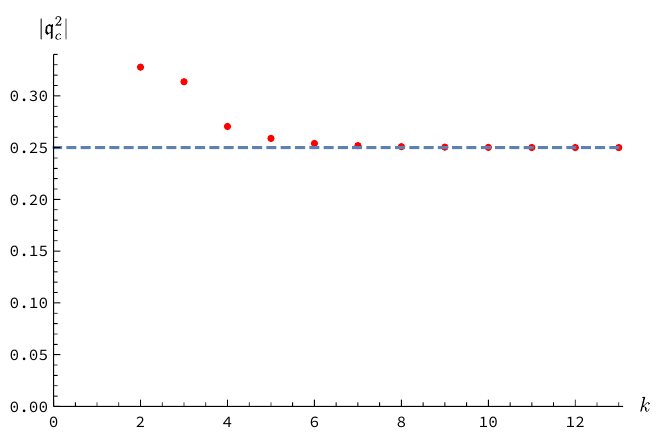
j = 1 = 4 in the holo- c